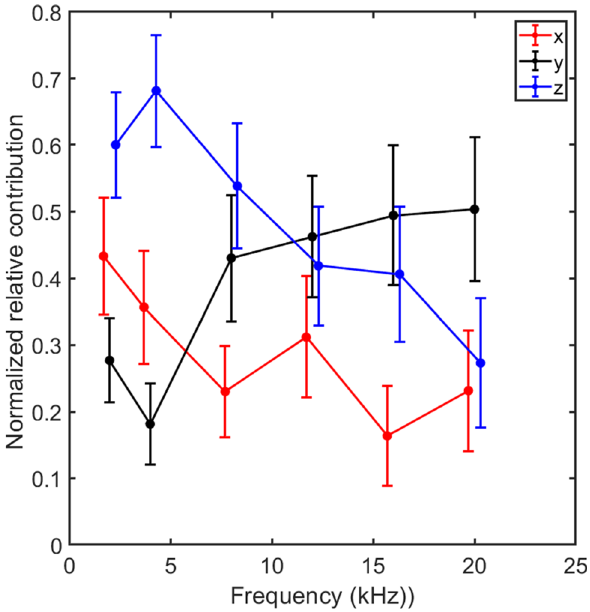
Figure 6. The normalized relative contributions on the hearing excitation from the x, y, and z direction BC vibrations at the cochlear promontory in guinea